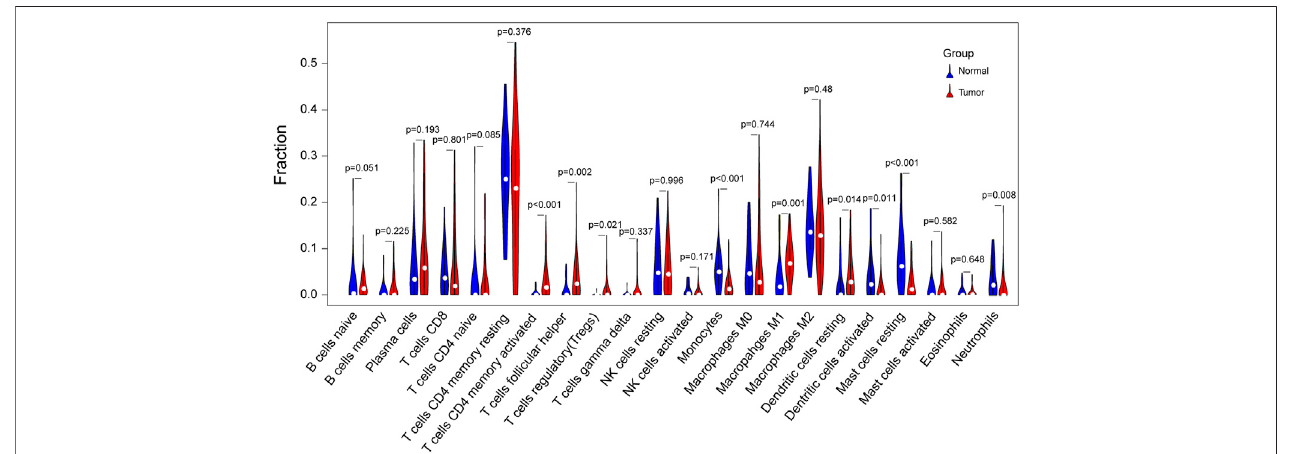
FIGURE 8 | Violin plot of differences in immune cell in fi ltration between SCLC and normal lung tissues. Comparison of 22 in fi ltrated immune cells in tumor samples and normal lung tissues based on four GSE datasets. Blue color represents normal lung tissue, while red represents tumor